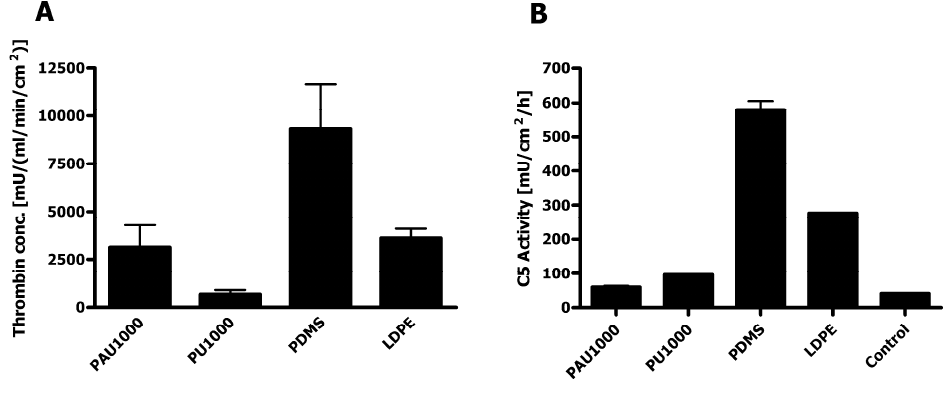
Figure 9. Haemocompatibility assessment. ( a ) Thrombin generation assay; ( b ) C5 complement convertase activity. Control materials used for comparison: 1,4-butanediisocyanate based polyurethane (PU1000), polydimethylsiloxane (PDMS) and low density polyethylene (LDPE) as the Gold standard (mean values of duplicate measurements ±